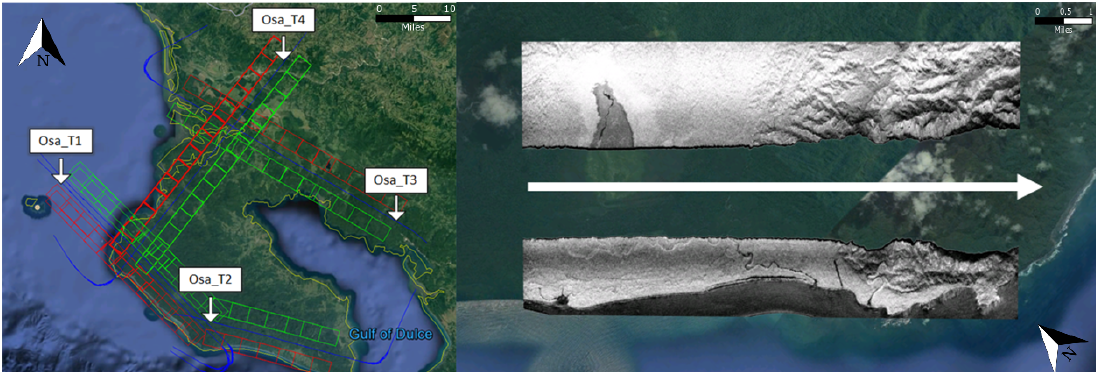
Figure 34. Flight lines of the collected EcoSAR data in Costa Rica in March 2014. Green and red boxes represent the image swaths on left and right respectively ( left ). Geocoded EcoSAR HH image of Osa_T1 analysed in this section. Data was acquired on both sides of the flight track simultaneously ( right